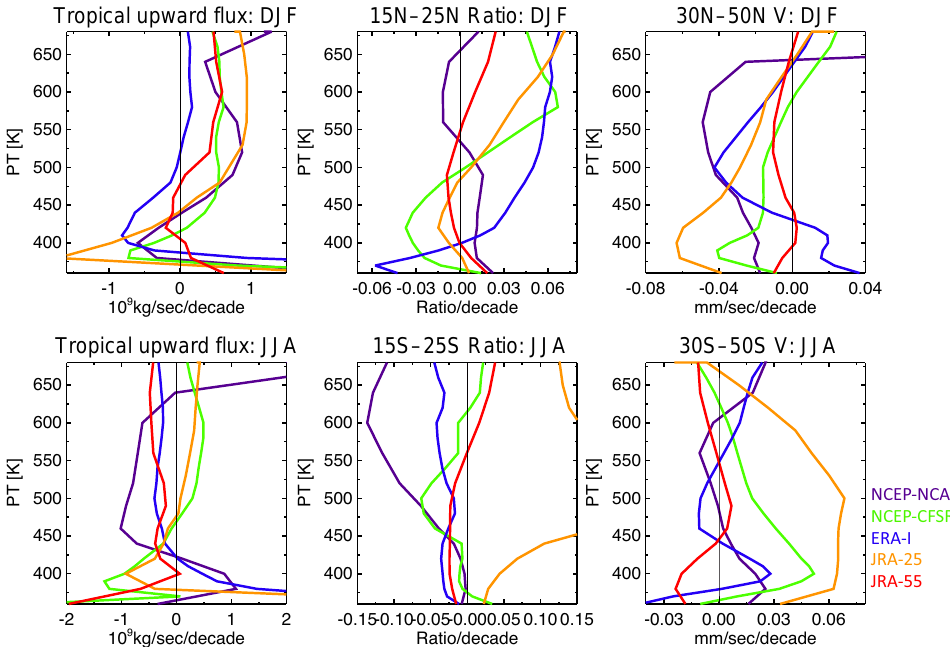
Figure 12. Same as Fig. 11 but for the last 12 years, 2001–2012.